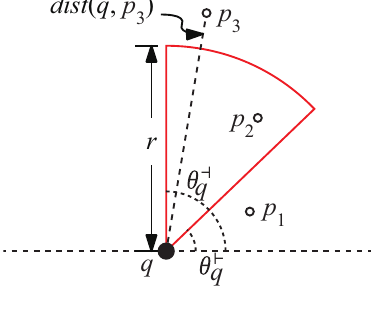
Figure 6. p 2 is inside the view field, but p 1 and p 3 are not.